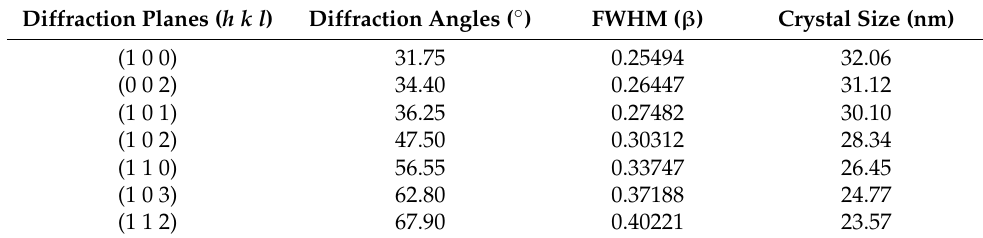
Table 1. Crystalline parameters for the CdO-ZnO nanocomposites. Diffraction Planes ( h k l